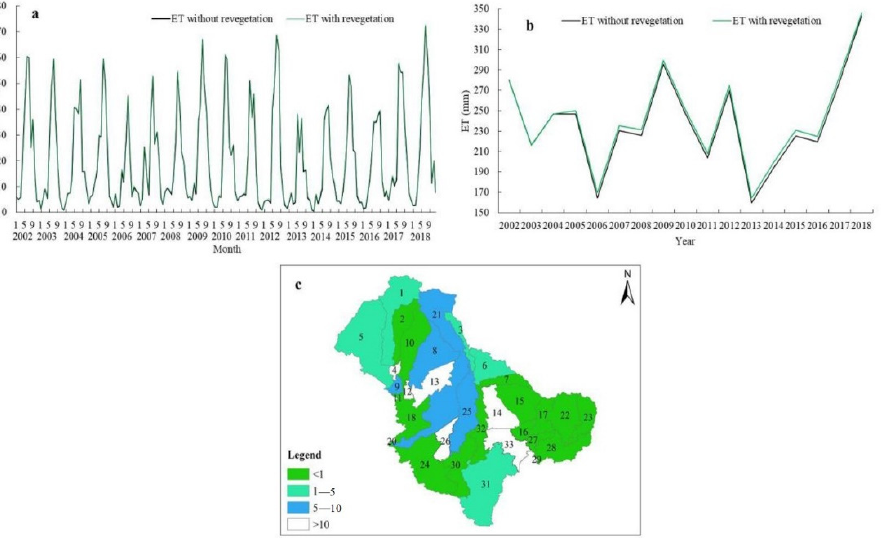
Figure 14. ( a ) Monthly and ( b ) yearly ET with revegetation and without revegetation; ( c ) yearly average ET change in different sub ‐ basins after revegetation.